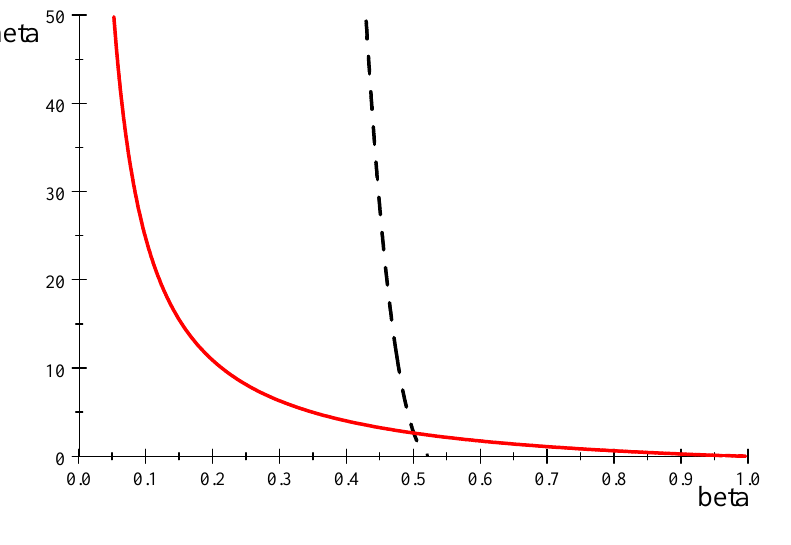
Figure 5: Changes of labour market tightness with respect to β :